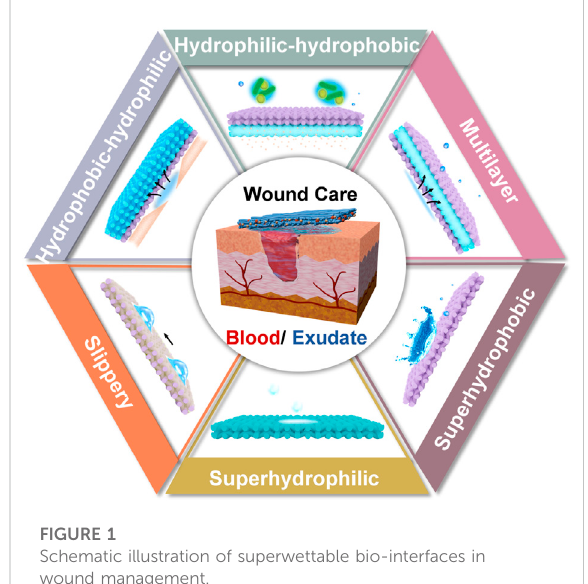
FIGURE 1 Schematic illustration of superwettable bio-interfaces in wound